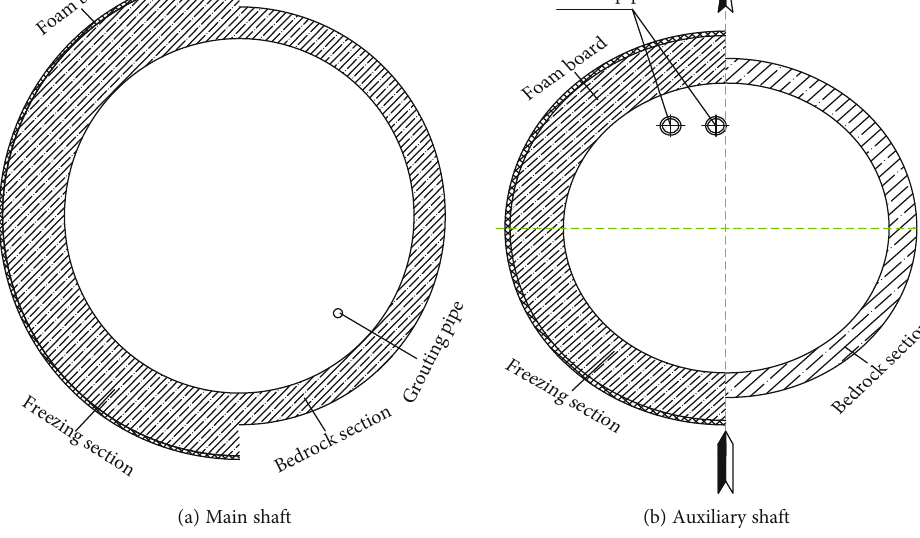
Figure 1: Shaft section view.